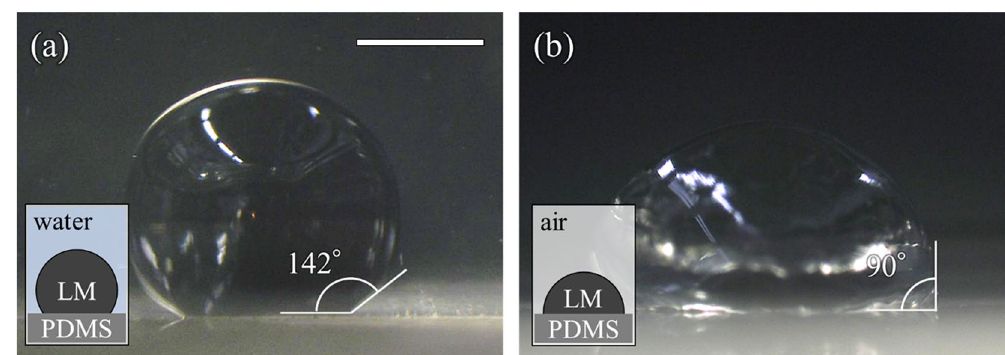
Figure 3. Contact angle of Galinstan droplet on PDMS-film. ( a ) Microscope images of the Galinstan droplet under water environment, and ( b ) under gas environment. The scale bar indicated 1 mm. The schematic insets show the experimental